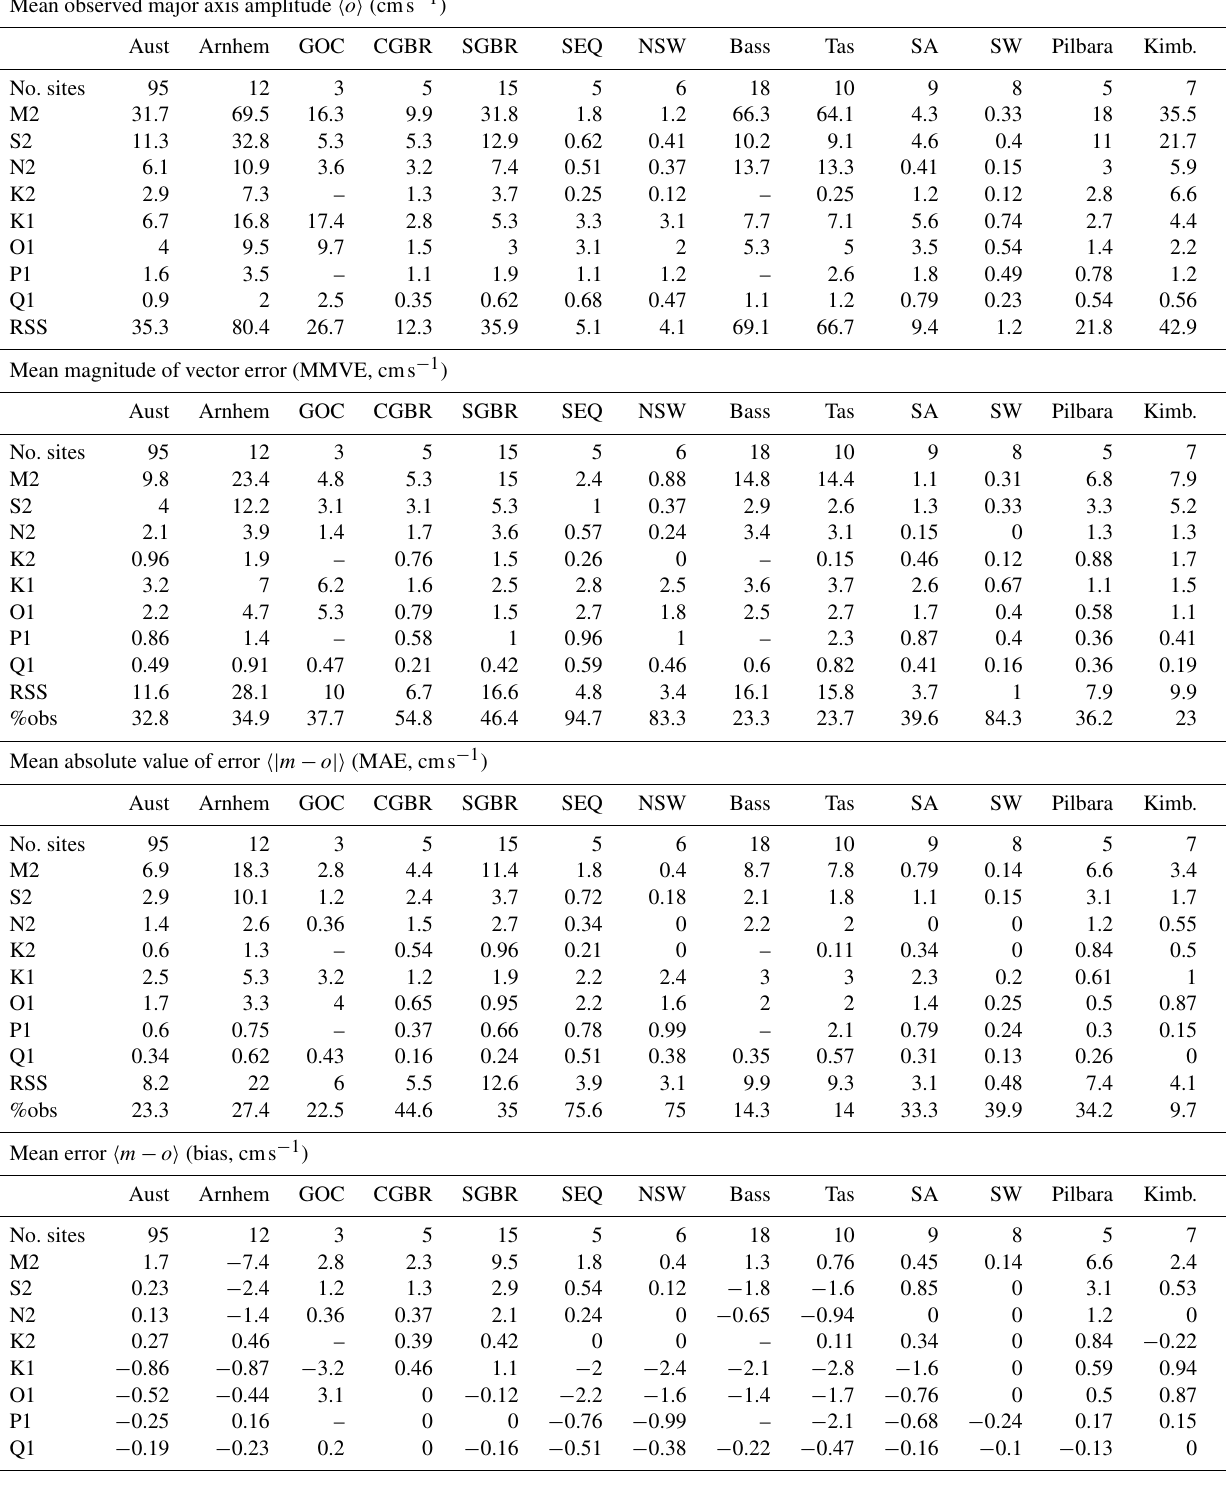
Table 4. Tidal major axis velocity and phase regionally averaged statistics for eight constituents (and their root sum of squares). Mean observed major axis amplitude (cid:104) o (cid:105) (cms − 1